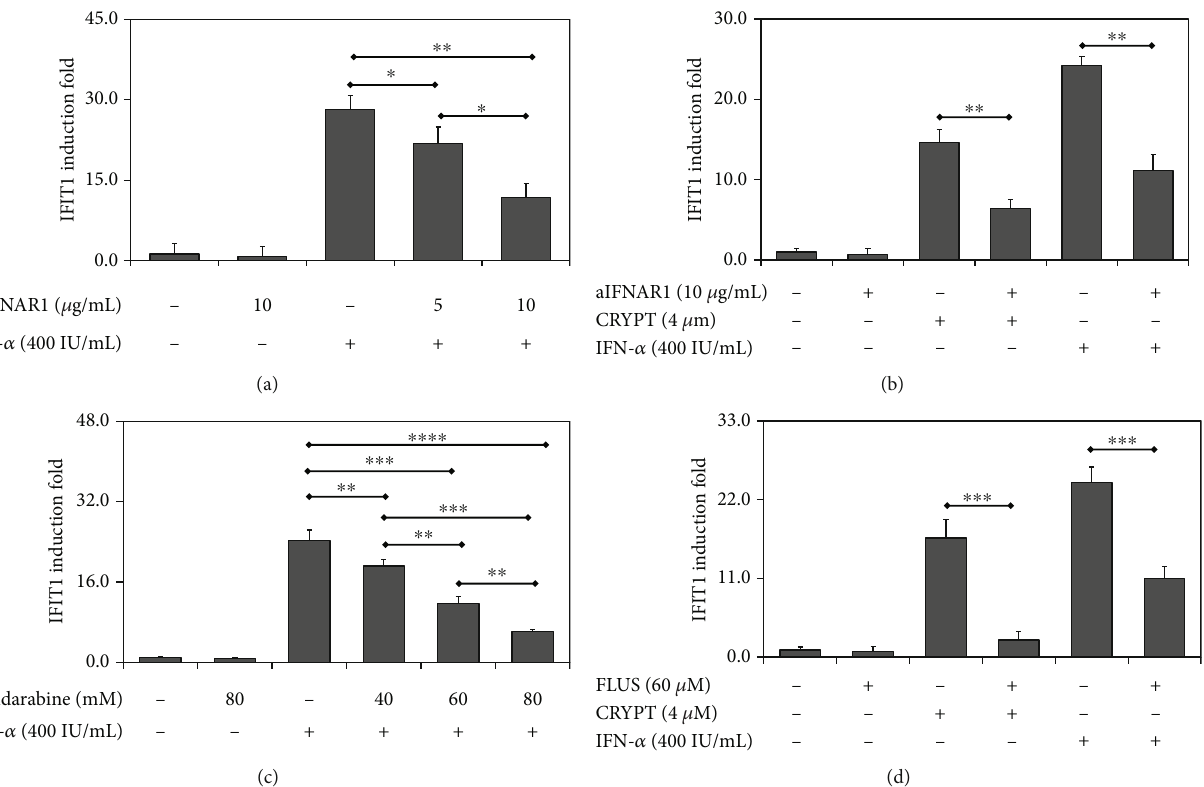
Figure 6: Cryptolepine activates IFN-1 response through IFNAR1 and STAT1 in THP1-derived macrophages. The derived macrophages from the parent THP1 cells were cocultured with the anti-IFNAR1 blocking antibody (aIFNAR1) and IFN- α (a) or cryptolepine (CRYPT) (b), and fl udarabine (FLUD) and IFN- α (c) or cryptolepine (d) and the IFIT1 induction was evaluated after 24h. Data are shown as the means, from three varied experiments with each done in triplicate, and error bars represent the standard deviations. ∗ p < 0 : 05 , ∗∗ p < 0 : 01 , ∗∗∗ p < 0 : 001 , and ∗∗∗∗ p < 0 : 0001 (one-way ANOVA and Bonferroni ’ s test (a and c) or Student ’ s t -test (b and